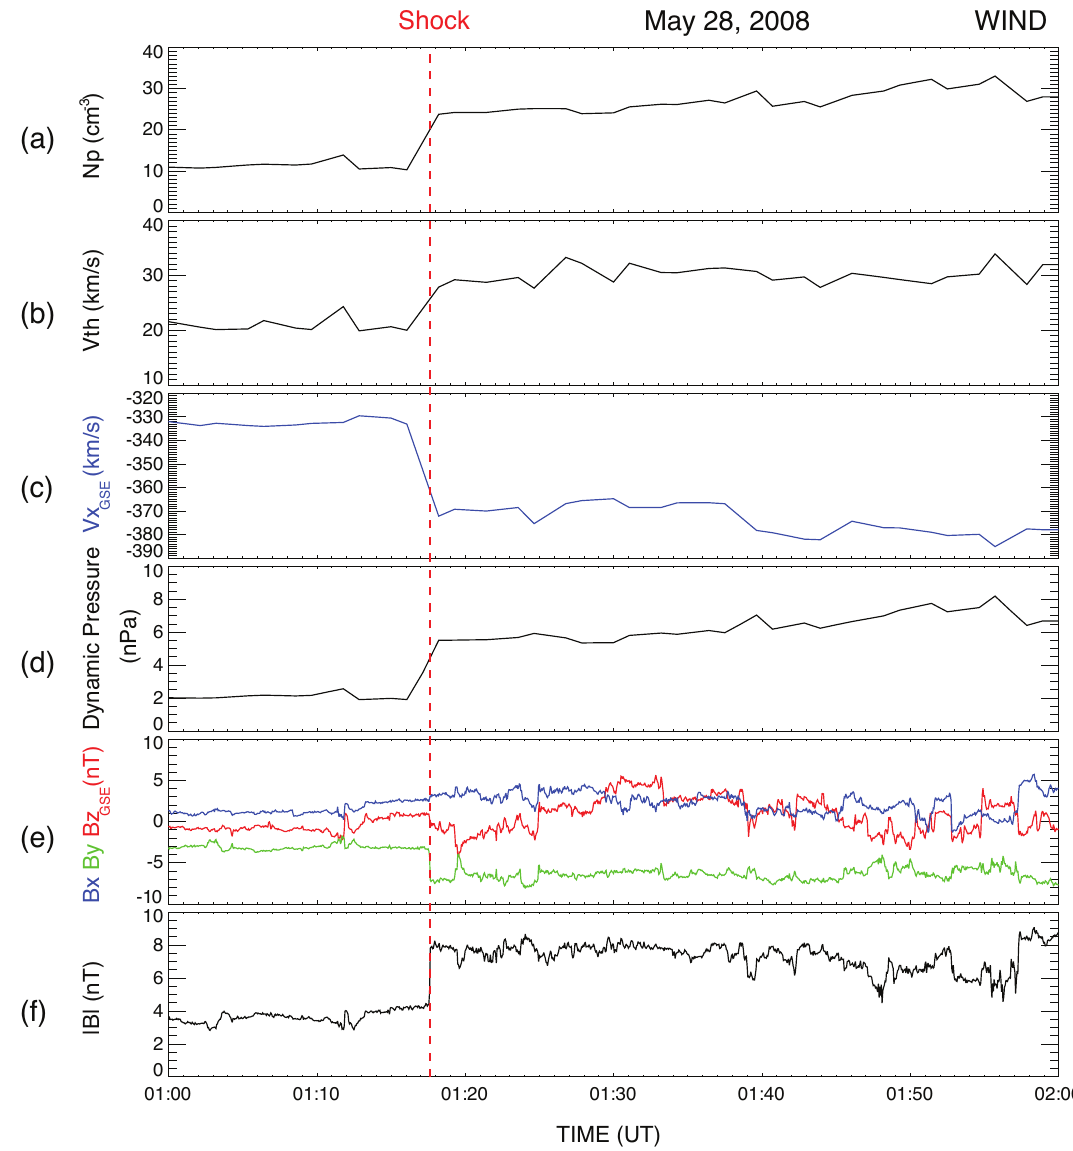
Fig. 1. An IP shock observed by the WIND spacecraft upstream at (257, 52, 23) R E . From top to bottom: (a) ion density, (b) thermal velocity, (c) component of the flow velocity V x along the Sun-Earth line, (d) dynamic pressure, (e) components of the magnetic fields in GSE coordinates, and (f) the magnetic field strength. The vertical dashed red line at 01:17:38UT marked the IP shock crossing.